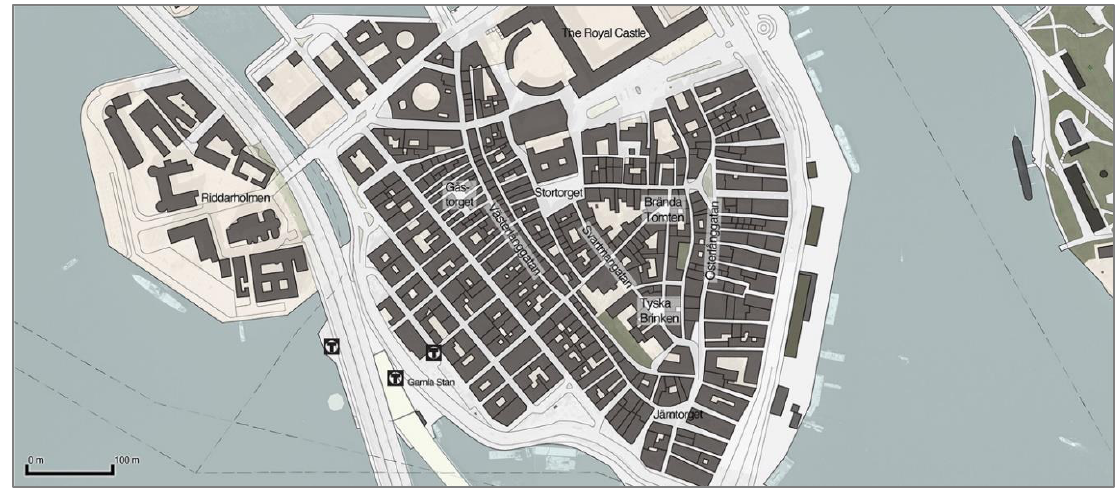
Figure 2 Tyska Brunnsplan; distance to Järntorget is 137.5 m / 115.5 m / 5 turns; distance to Västerlånggatan is 147.75 m / 76 m / 2 turns / (107.8 m to intersection); distance to Stortorget is 162.5 m / 160.4 m / 2 turns; distance to the nearest subway station is 413 m / 295.5 m / 3-4 turns; distance to the Royal Castle is 284 m / 242.5 m / 3-4 turns (4 to entry, 3 to square). Brända Tomten: distance to Stortorget is 142 m / 115 m / 2 turns; distance to Järntorget is 305 m / 230 m / 5 turns; distance to Västerlånggatan is 157 m / 154 m / 2 turns; distance to the nearest subway is 368 m / 315 m / 4-5 turns; distance to the Royal Castle is 173.5 m / 131 m / 3-4 turns. Tyska Brunnsplan, August 31, 2021,